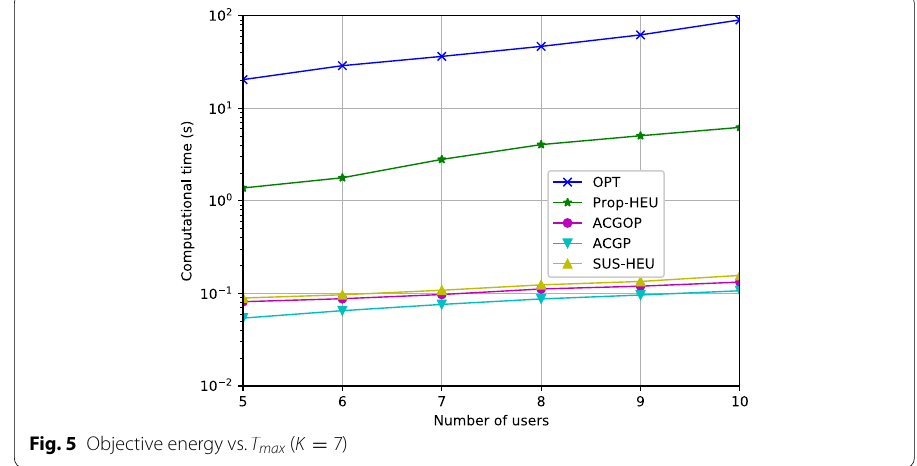
Fig. 5 Objective energy vs. T max ( K = 7 )